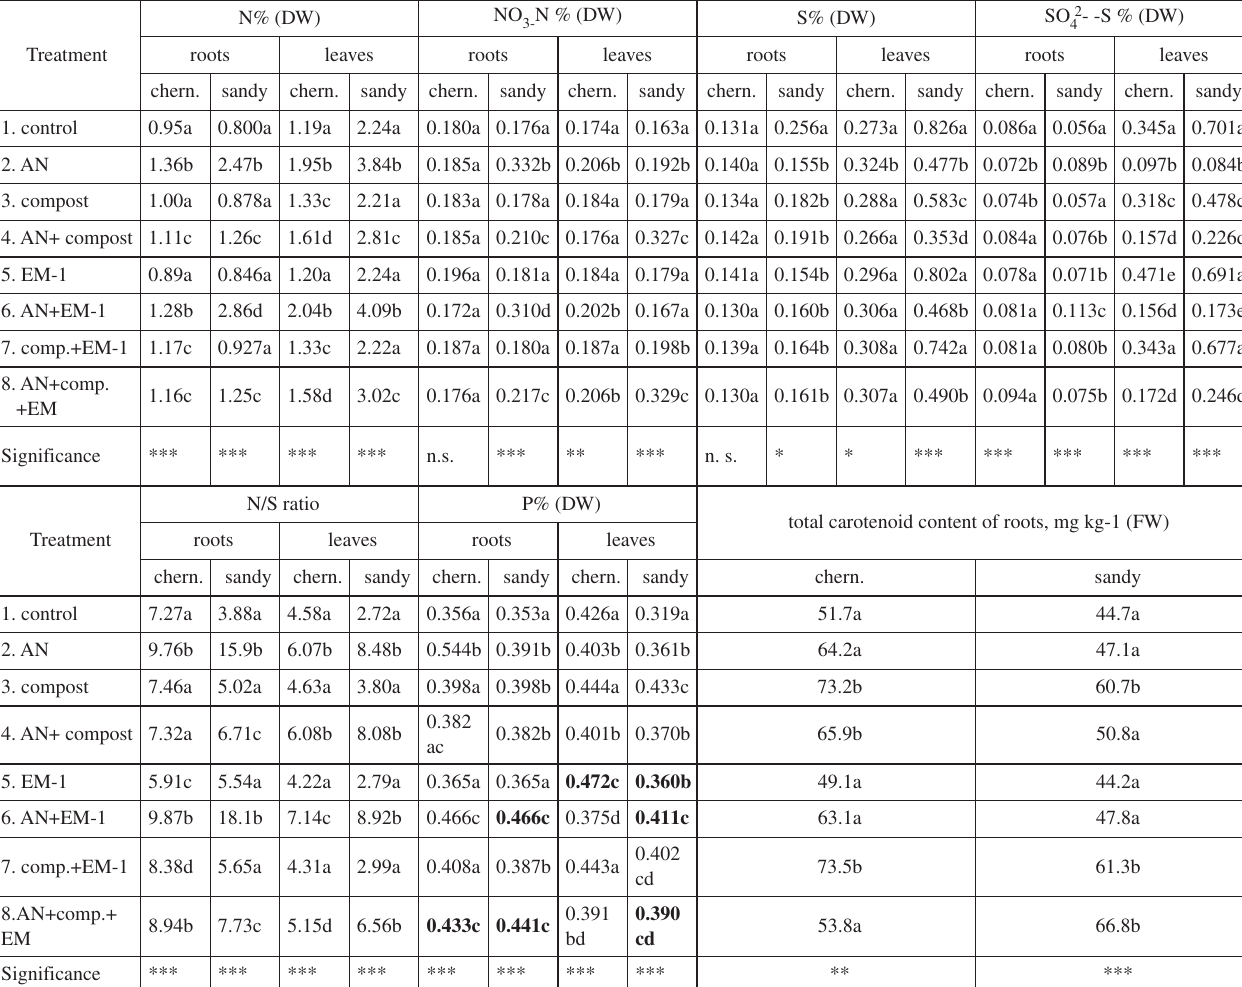
Table 5. Effects of treatments on nutrient and carotenoid contents of